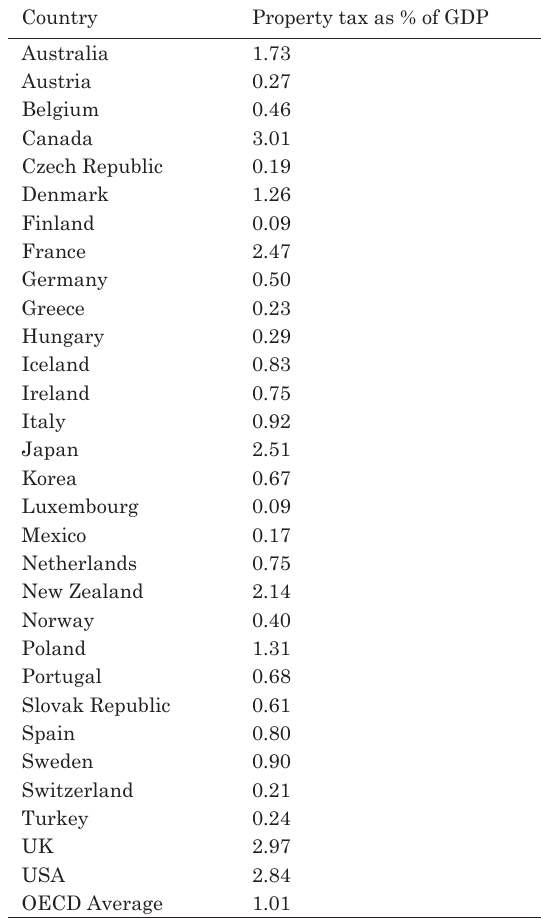
table 3. Property tax as % of GDP for